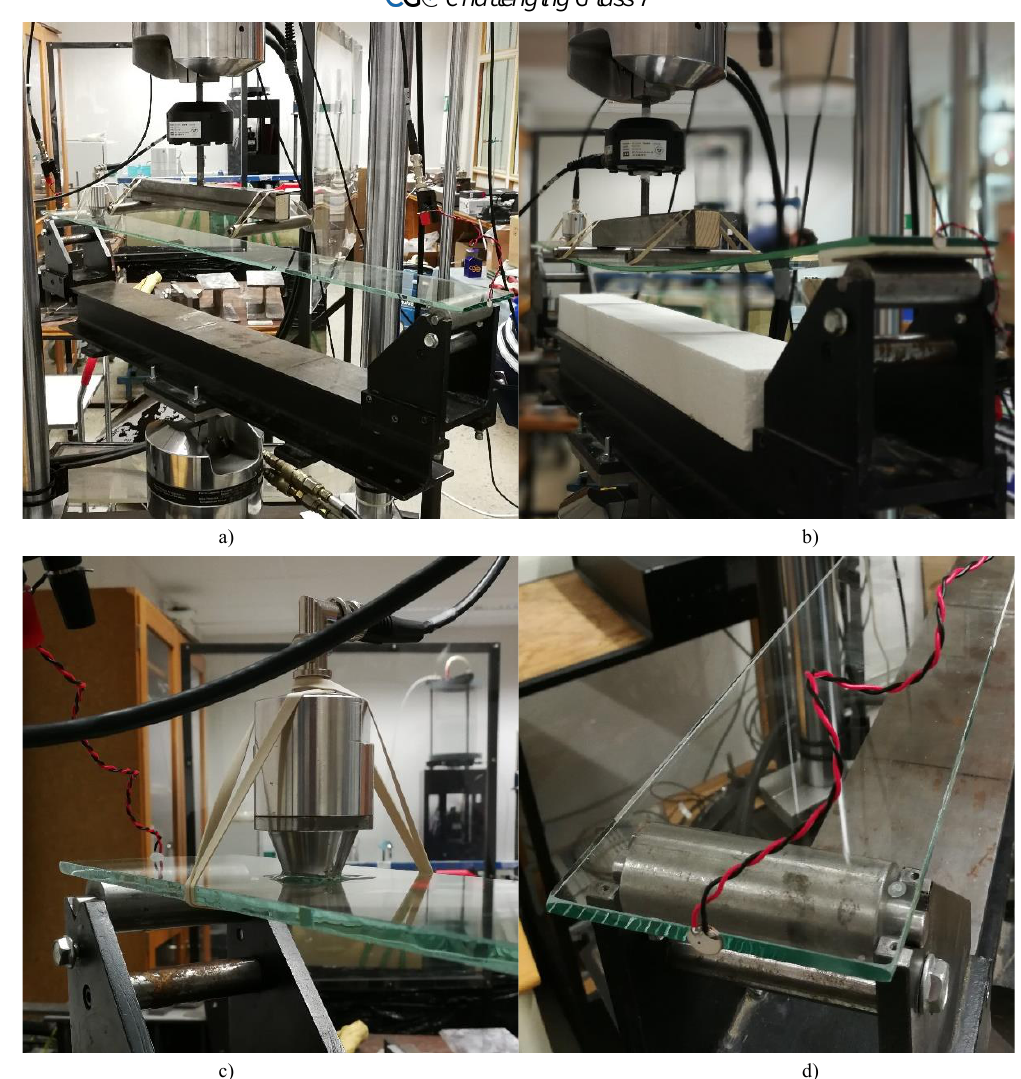
Fig. 5 Non-linear ultrasonic measurement at simultaneous load in test machine showing a) test set-up, b) visible deformations during testing, c) ultrasonic transducer on the edge and a low frequency transmitter on the top of the sample, d) ultrasonic transducer at other end.